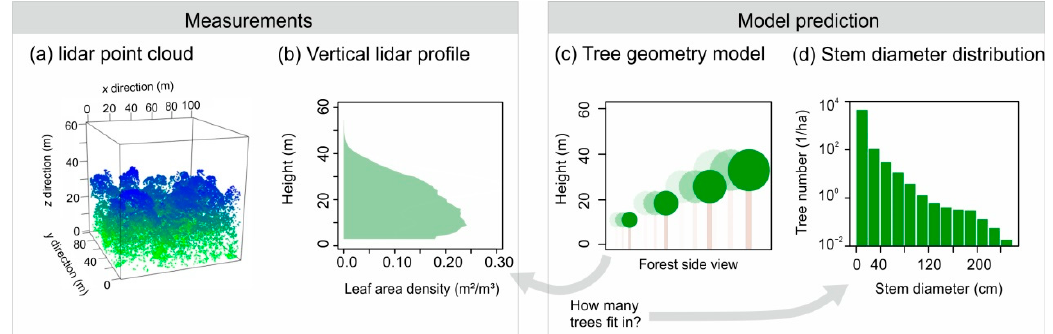
Figure 1. Combination of light detection and ranging (lidar) measurements with the tree geometry model to estimate the stem diameter distribution of a forest. The starting point is ( a ) the measured lidar point cloud (here shown for an exemplary 1 ha subplot of Barro Colorado Island (BCI)). Points are colored according to their height (with a gradient from the top with blue colors to the bottom with green colors). ( b ) The vertical leaf area profile can be derived from the lidar point cloud by accounting for decreasing lidar returns with decreasing height due to the tree leaf density (ground returns of height < 3 m are not shown). The vertical leaf area profile is then combined with the tree geometry model illustrated in ( c ). By calculating how many trees of specific size (illustrated by different shadings) can contribute tree crown leaves to the lidar -derived leaf area profile, we can estimate ( d ) the number of trees (per ha) in specific stem diameter classes (here, logarithmic y-axis, 50 ha plot of BCI, 20 cm diameter class width). See methods for